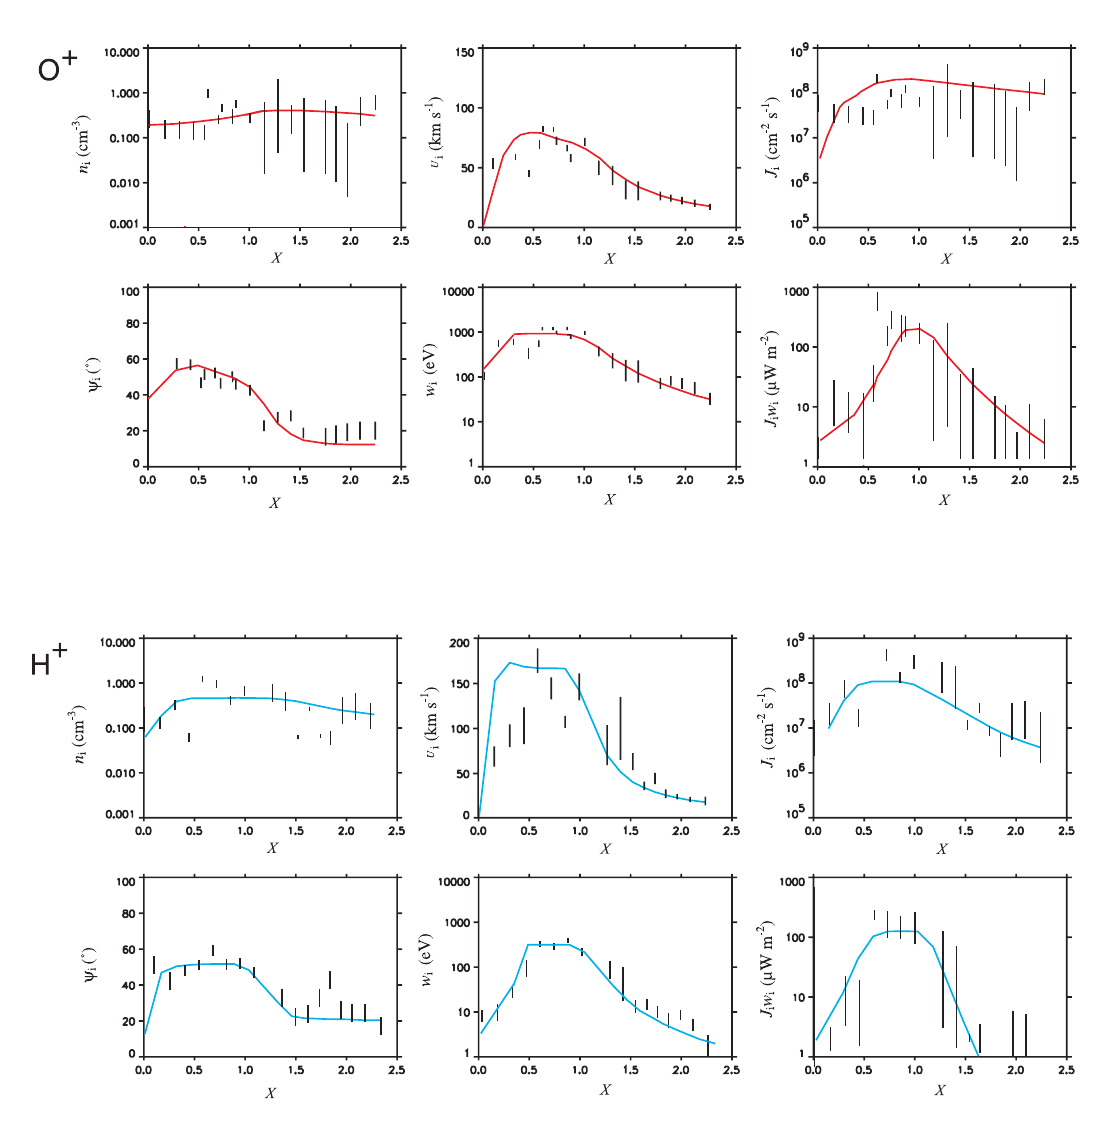
Fig. 9. Comparisons of experimental ion moments along the satellite track for event 2 with those from a numerical simulation (solid curves) for O + (top) and H +